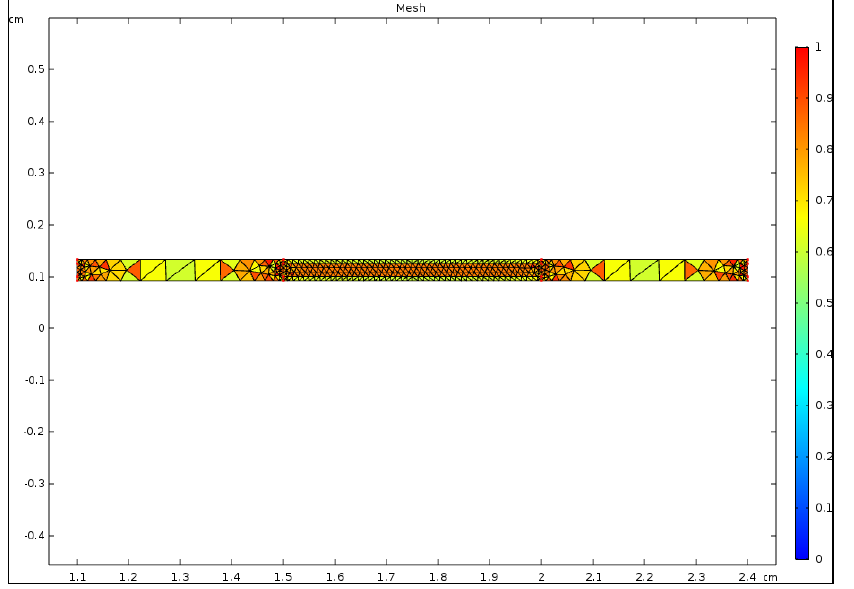
Figure 3. Mesh Distribution.